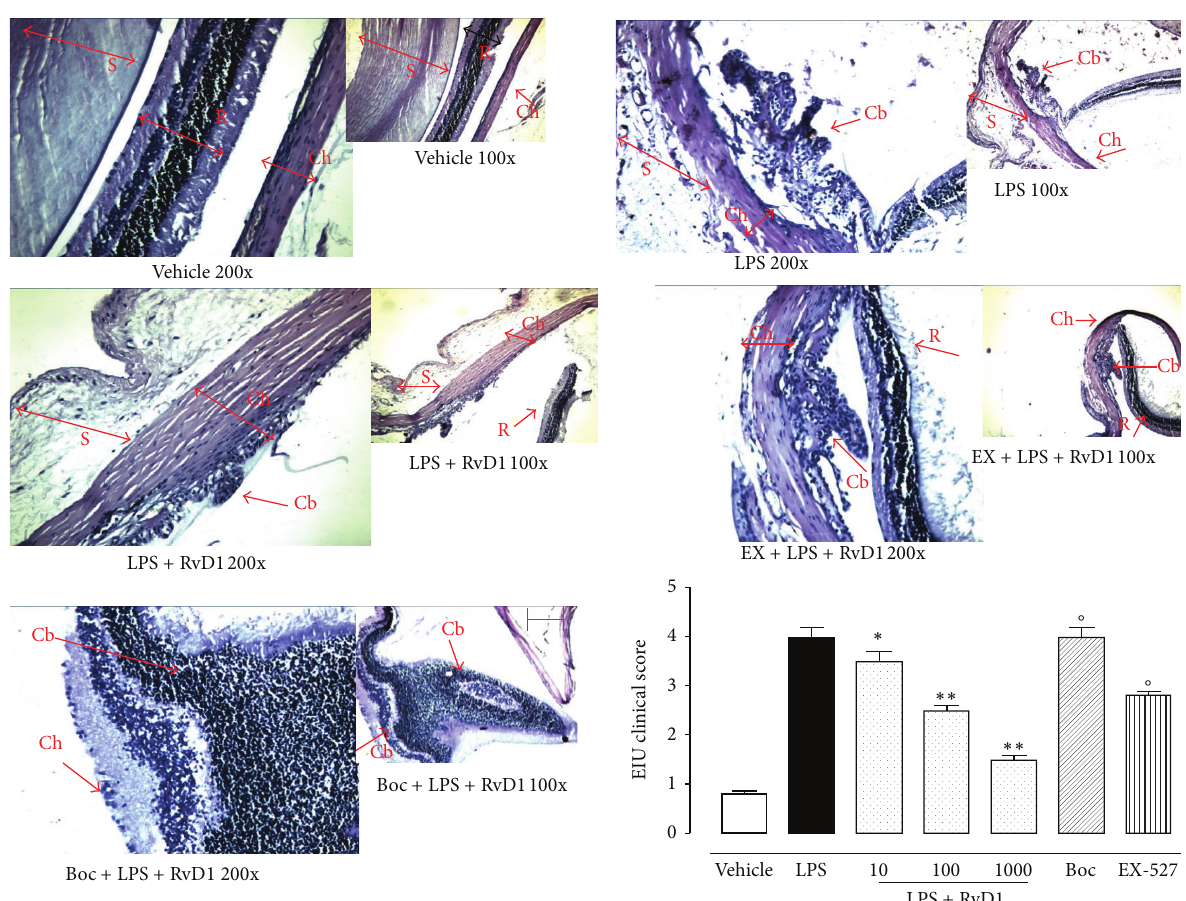
Figure 1: Resolvin 1 and sirtuin-1 in clinical development of EIU. Vehicle (saline + ethanol) and resolvin 1 (RvD1, 10–100–1000ng/kg) were injected into the vitreous of rats 1 hour after vehicle + LPS (200 𝜇 g/rat) treatment. Clinical manifestations of EIU were evaluated 24 hours later both with hematoxylin and with eosin (representative pictures of RvD1 1000 ng; magnification: 100x and 200x, scale bar = 100 𝜇 m) and scored as reported in text (see Section 2). This figure also shows the effects of pretreatment with compound EX-527, an inhibitor of sirtuin-1 activity (10mg/kg/day, i.p. for 7 days), prior to LPS and LPS + RvD1 (1000ng/kg), and the effects of treatment with RvD1 FPR2/ALX Boc2 receptor antagonist (0.4 mg/kg/4 𝜇 L) into the vitreous (30min prior to RvD1 1000 ng/kg). Values are reported as the mean ± S.E.M.; 𝑛 = 6 observations for each group. ∗ 𝑃 < 0.05 and ∗∗ 𝑃 < 0.01 versus LPS-treated rats; ∘ 𝑃 < 0.01 versus RvD1